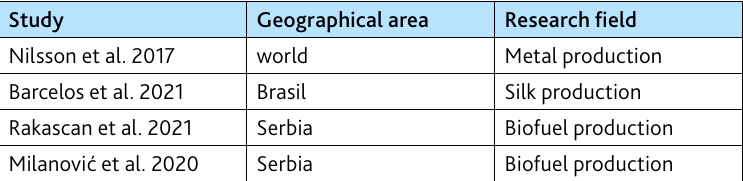
Table 3. Studies of material production identified in this review Study